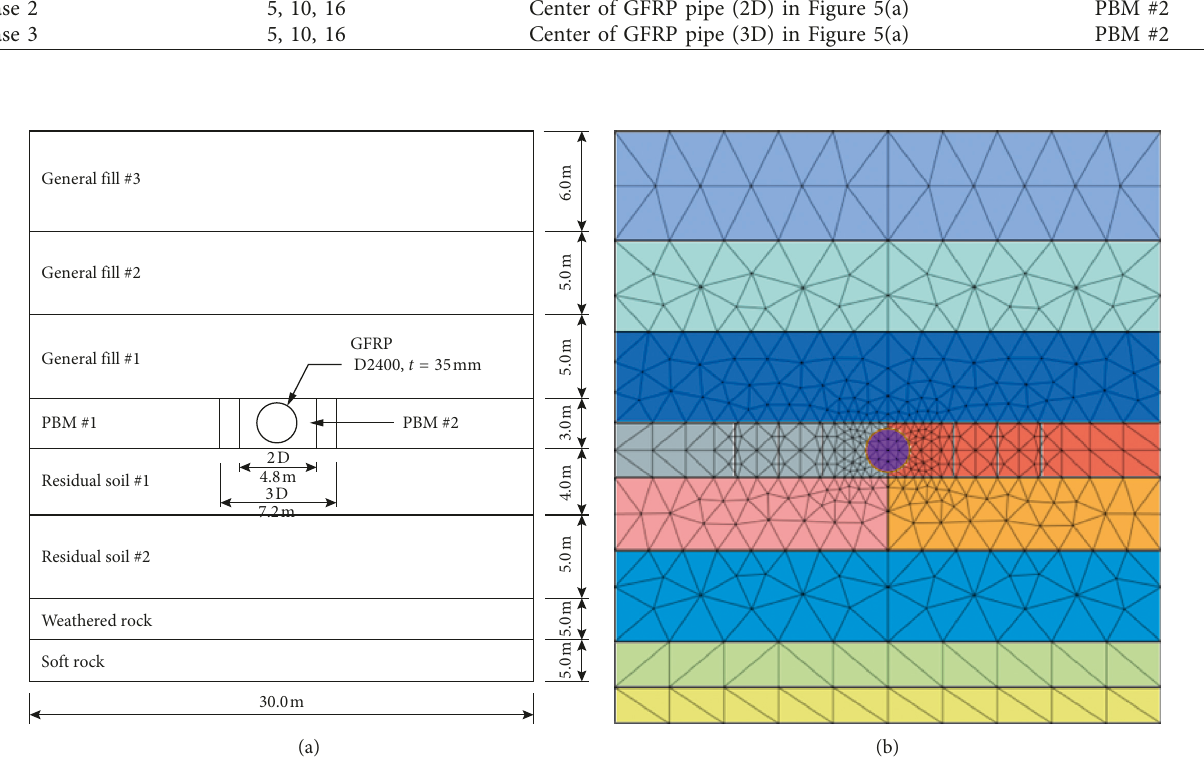
Figure 4: Finite element analysis model. (a) Schematic view. (b) Finite element analysis mesh model